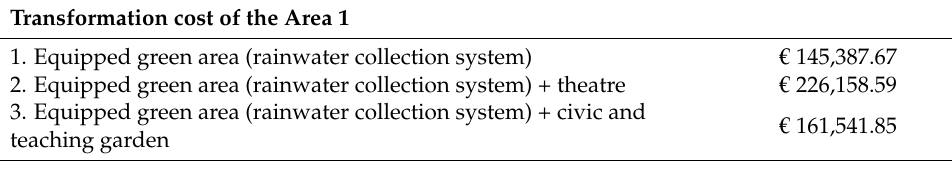
Table 3. Transformation costs for the different project alternatives of the two areas. Transformation cost of the Area